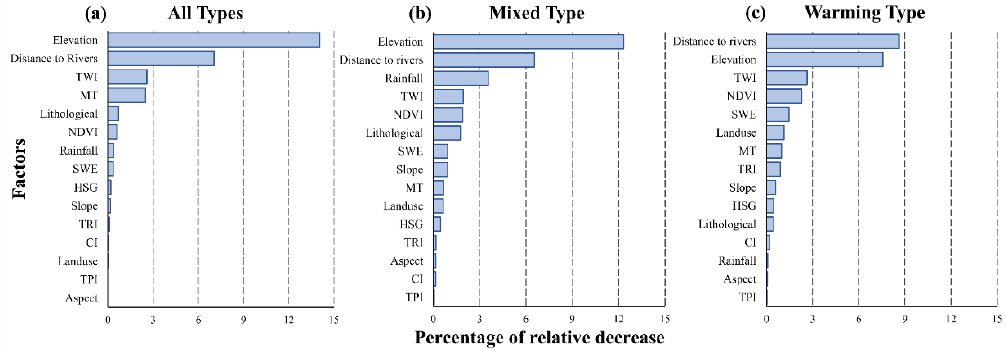
Figure 11. Sensitivity analysis results.